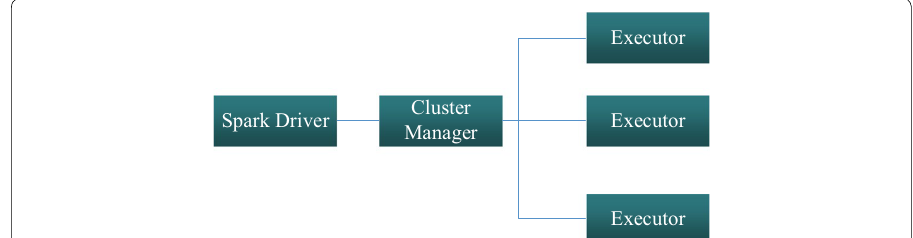
Fig. 6 High level architecture of Apache Spark